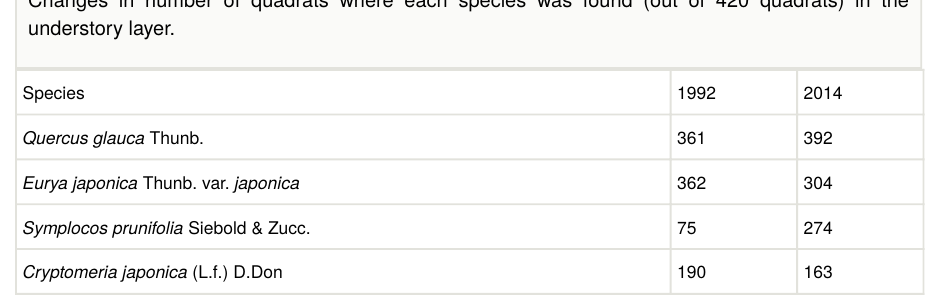
Table 2. Changes in number of quadrats where each species was found (out of 420 quadrats) in the understory